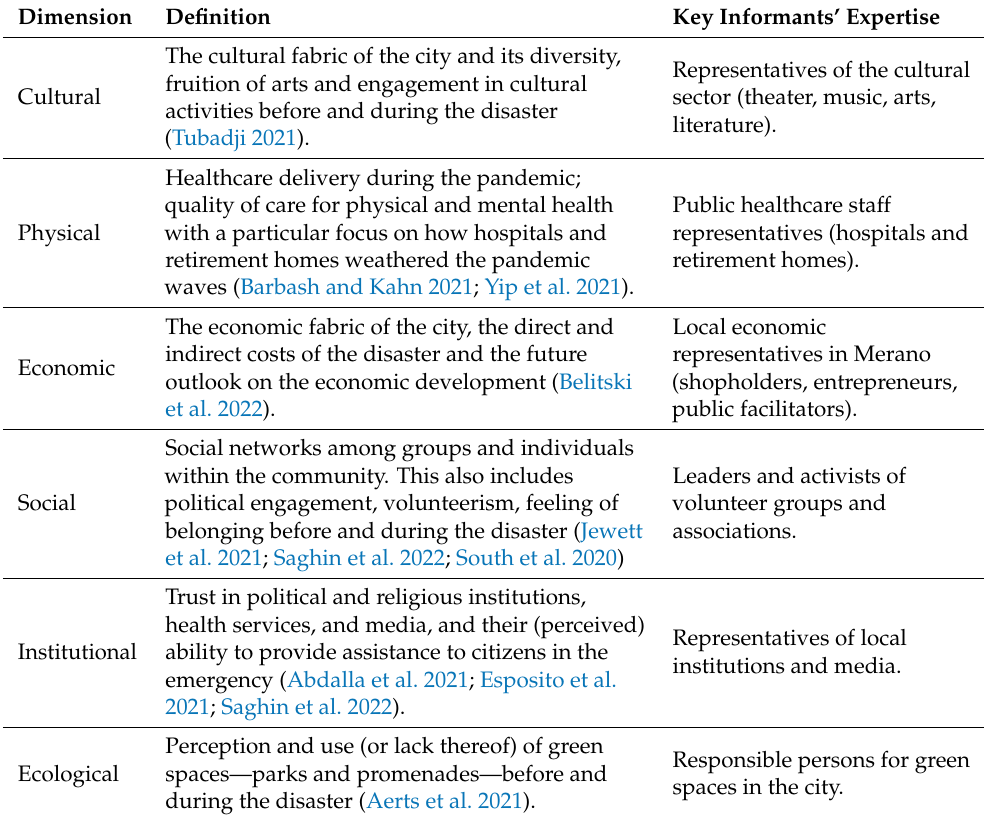
Table 1. Definition of the six dimensions of CR adapted to the case study of